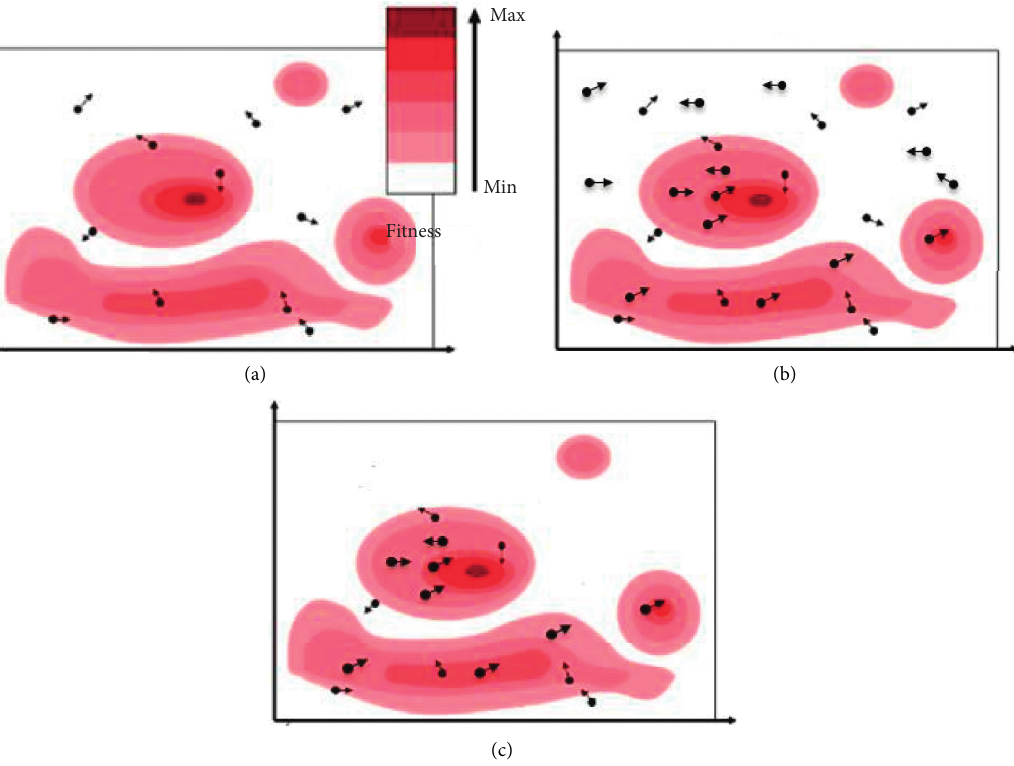
Figure 4: The proposed modification of MAPSO algorithm. (a) Standard PSO algorithm. (b) MAPSO. (c) After selecting the best pop. of the